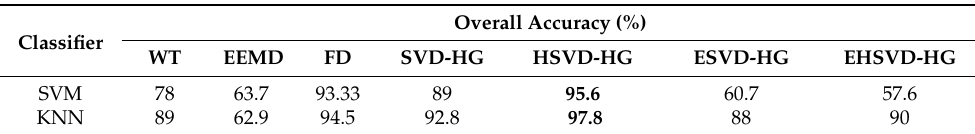
Table 4. Case Study-I: Singular-Hyper Feature Performance-Comparison with [14] (for Different PD Location).